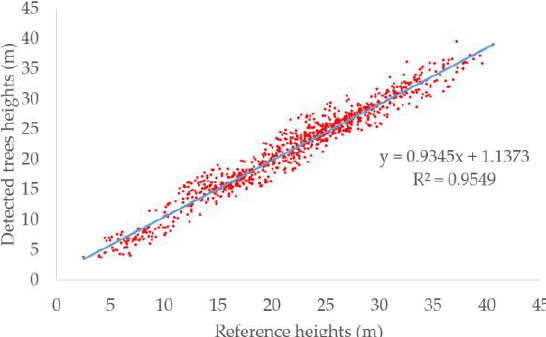
Figure 6. Scatter plots of detected tree height and reference height. The blue line is the fitted line.